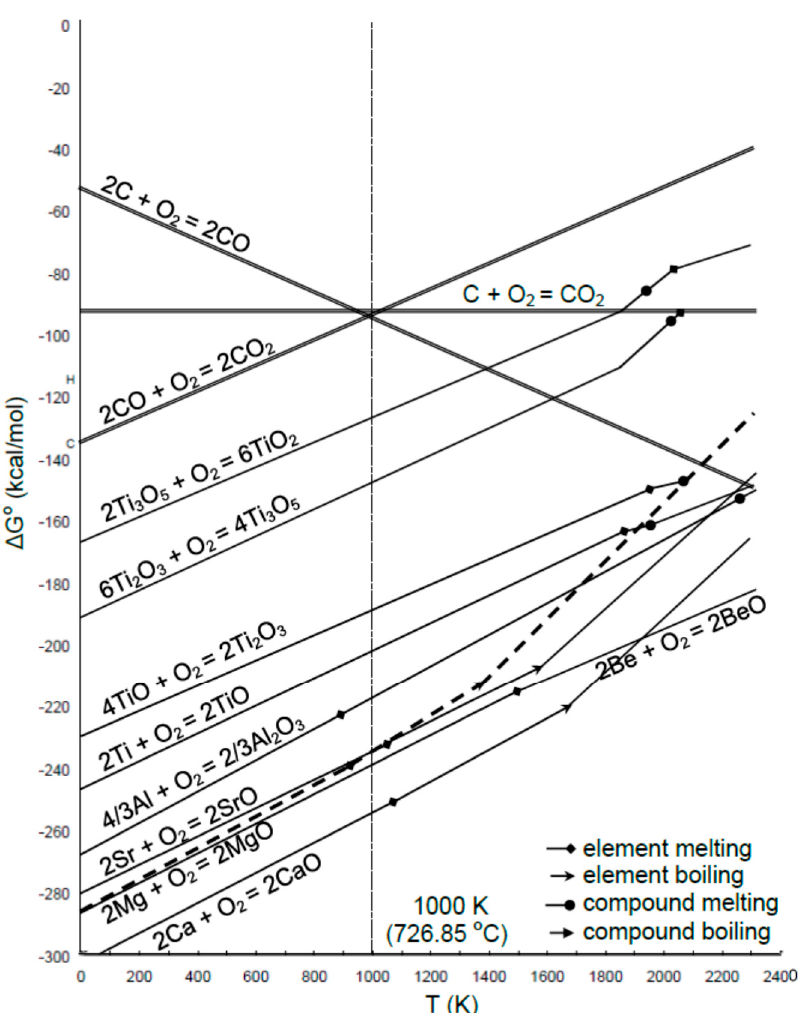
Figure 1. Schematic of the Ellingham diagram for selected oxides [33,34]. Mg oxidation is marked with a dashed line. Adapted from [34], copyright (2006), reprinted with permission of Stanley M. Howard.